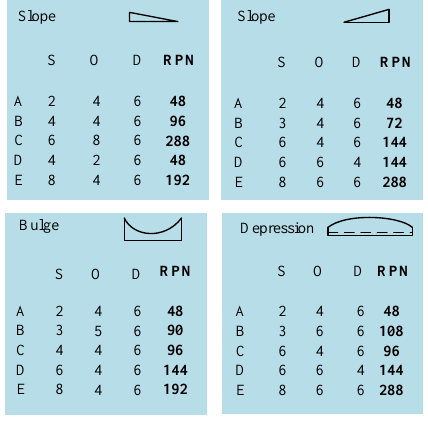
Figure 2. MDF’s FMEA grade analysis chart.